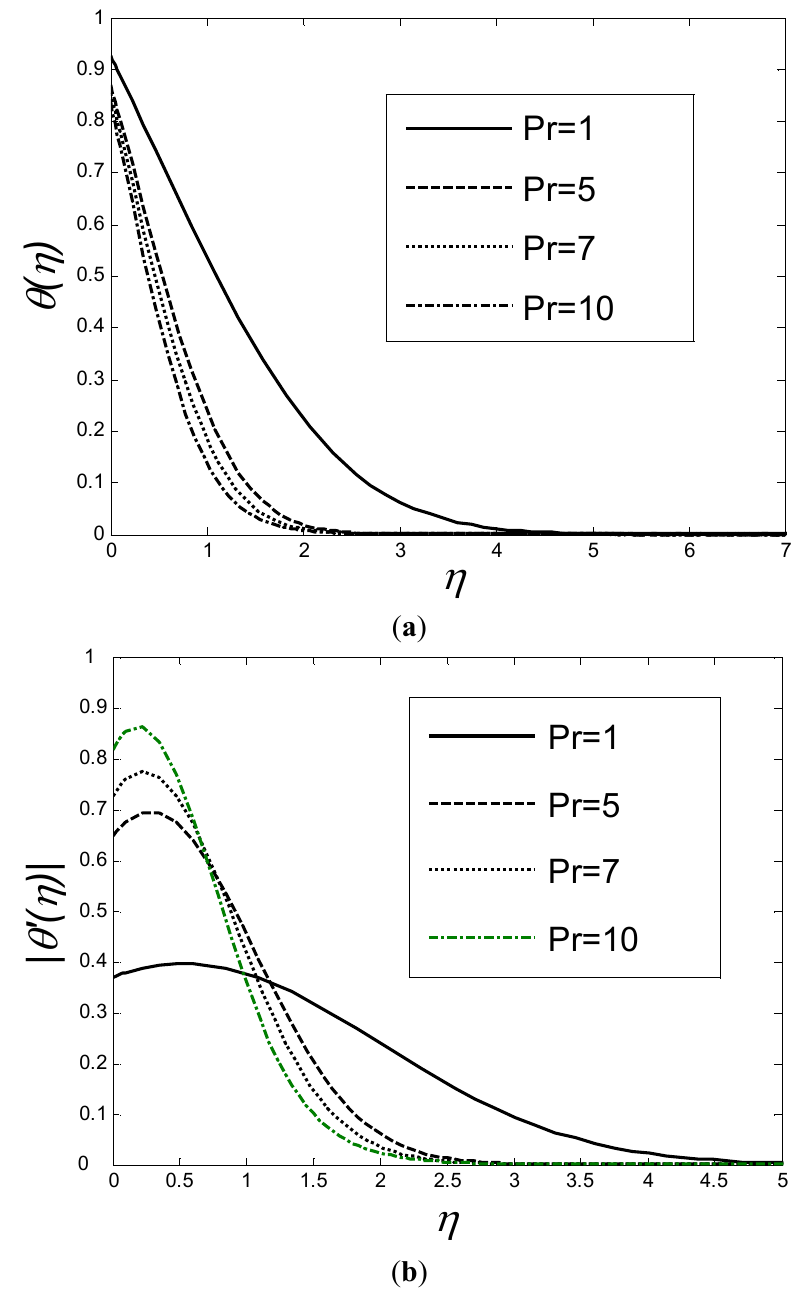
= 0.2, M = 0.5 and Ec = w